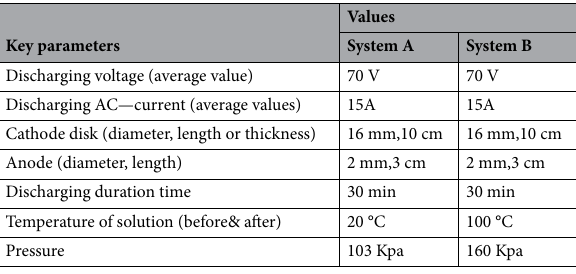
Table 1. The important parameters used in the